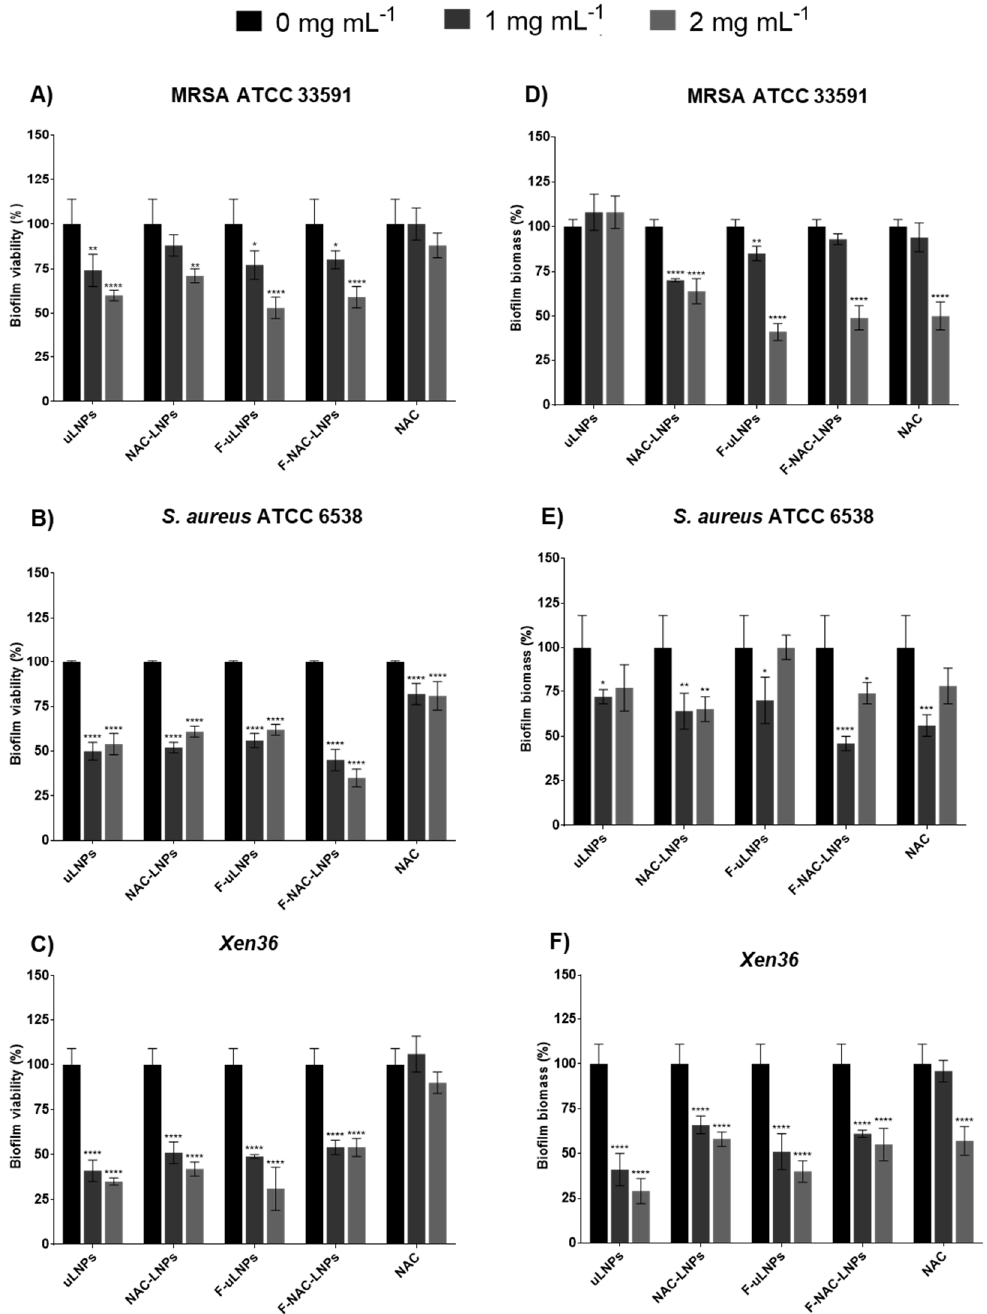
Figure 5. Quantification of ( A – C ) biofilm viability (XTT assay) and ( D – F ) biomass (crystal violet staining) after a 24 h treatment with LNP suspensions at the solid lipid concentrations of 0, 1, and 2 mg mL − 1 . Free NAC was tested at the concentrations of 0, 0.45, and 0.9 mg mL − 1 . The biofilms of ( A , D ) MRSA ATCC 33591, ( B , E ) S. aureus ATCC 6538, and ( C , F ) the bioluminescent strain Xen36 were grown in 96-well plates for 24 h prior to the treatment. Untreated biofilms (0 mg mL − 1 of solid lipid) were used as a positive control, and TSB 0.6x supplemented with 0.2% ( w/v ) glucose was used as a negative control. The values are presented as the mean ± SD. * p < 0.05, ** p < 0.01, *** p < 0.001, **** p < 0.0001 relative to 0 mg mL − 1 . Statistical analysis: two-way ANOVA, Dunnett’s multiple comparisons test.